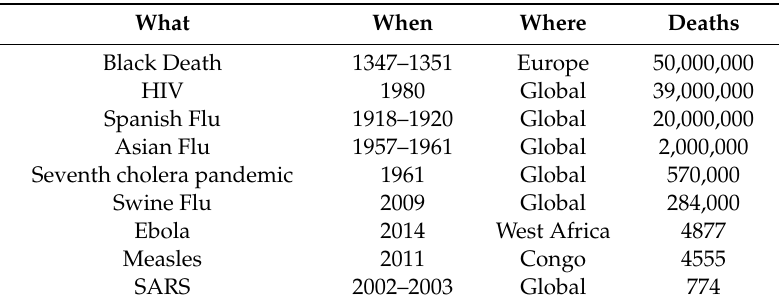
Table 1. Historic and recent epidemics / pandemics